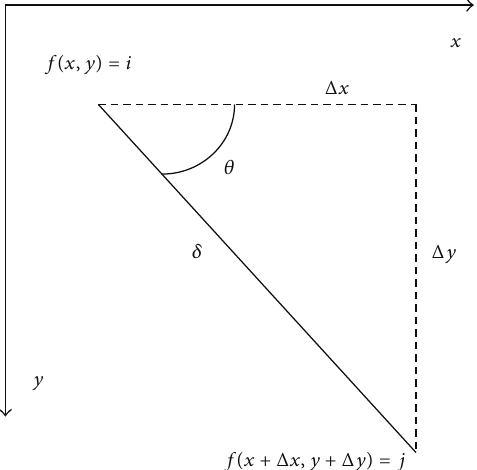
Figure 6: Grey-level cooccurrence